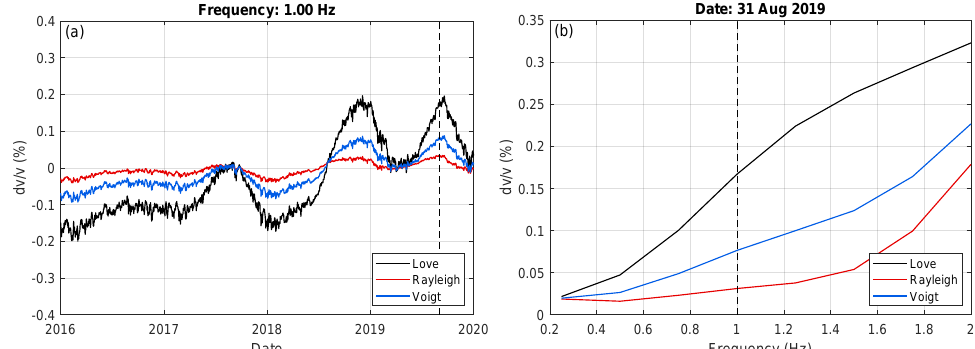
Figure 9. ( a ) Modeled surface-wave velocity changes, for example, frequency 1 Hz as a function of date, and ( b ) for the example date 31 August 2019 as a function of frequency. The individual lines represent velocity change in Love waves (black), Rayleigh waves (red) and their Voigt average ( dv / v ) = 2 ( dv / v ) + 1 ( dv / v ) Love Voigt Rayleigh 3 3